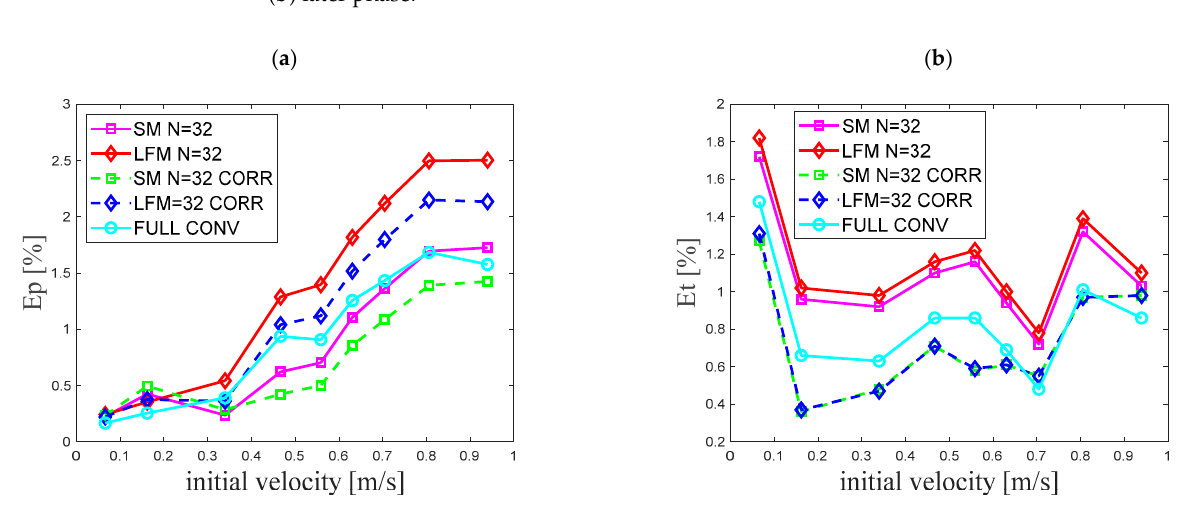
Figure 11. Simulation results after pressure wave correction (Case 09, Re = 15,850): ( a ) initial phase; ( b ) later phase.